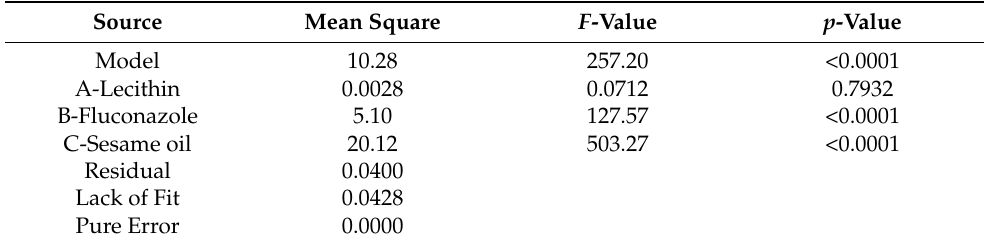
Table 6. Statistical outcome (ANOVA) for the linear model showing the interactions between the three independent variables and the ulcer index of the